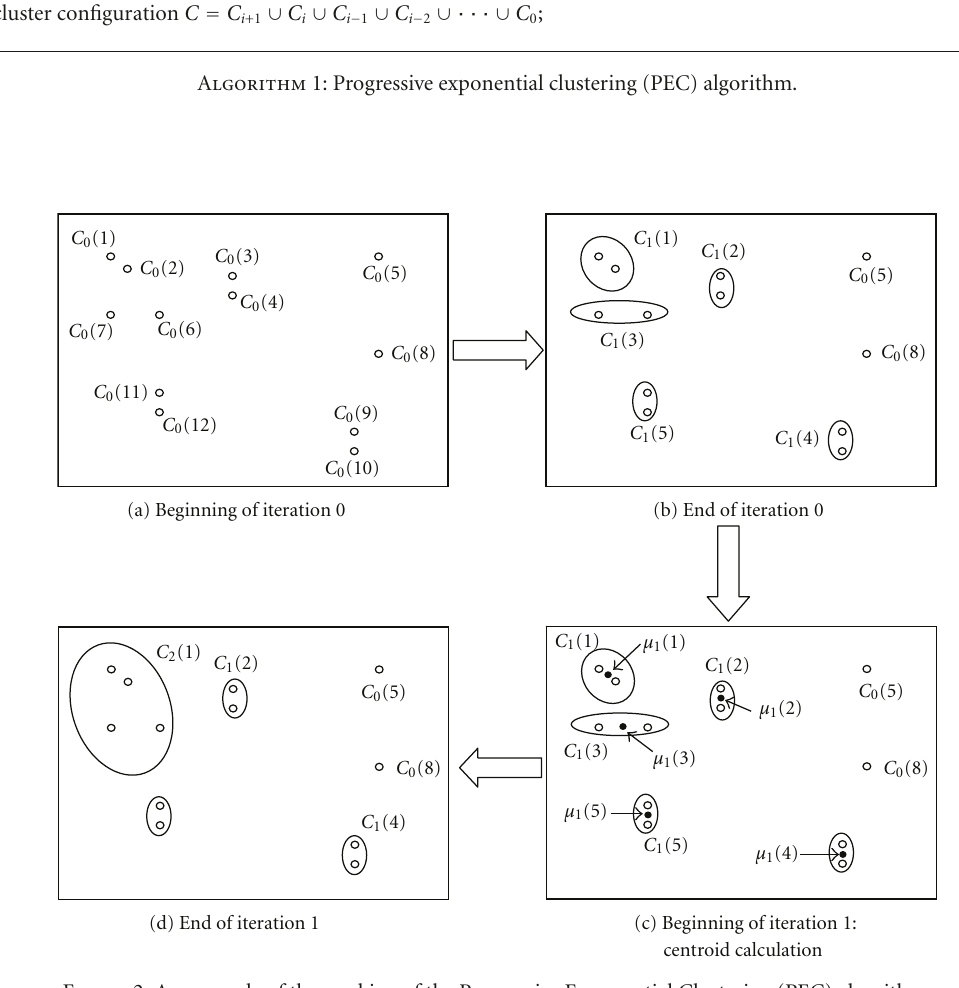
Figure 2: An example of the working of the Progressive Exponential Clustering (PEC)